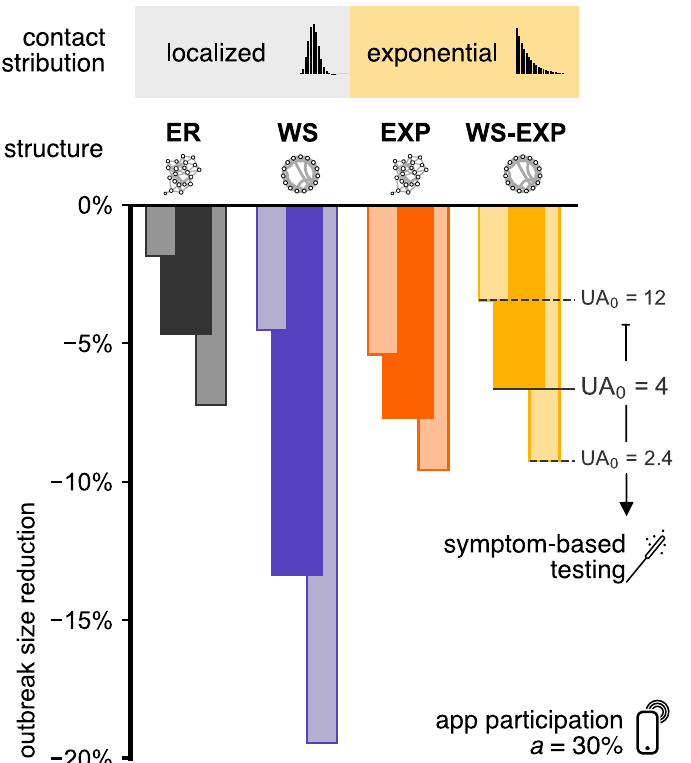
Fig 3. Relative mean outbreak size reduction 1 − h O ( a = 30%) i / h O ( a = 0) i caused by DCT in different network topologies. App participation was fixed at a = 30%, and symptom-based testing was assumed to lead to initial under- ascertainment factors of UA 0 2 {12, 4, 2.4} ( q = 0.1, 0.3 and 0.5, respectively). Note that h O ( a = 0) i depends on the baseline under-ascertainment factor UA 0 as well as the contact structure, see also Fig 7. DCT has a stronger effect in WS networks (purple) compared to the ER, EXP and WS-EXP networks. Increasing symptom-based testing (i.e. decreasing the under-ascertainment factor) enhances the efficacy of